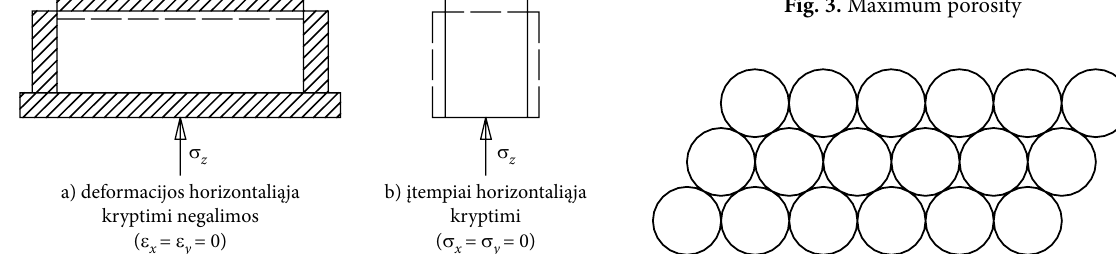
Fig. 3. Maximum porosity